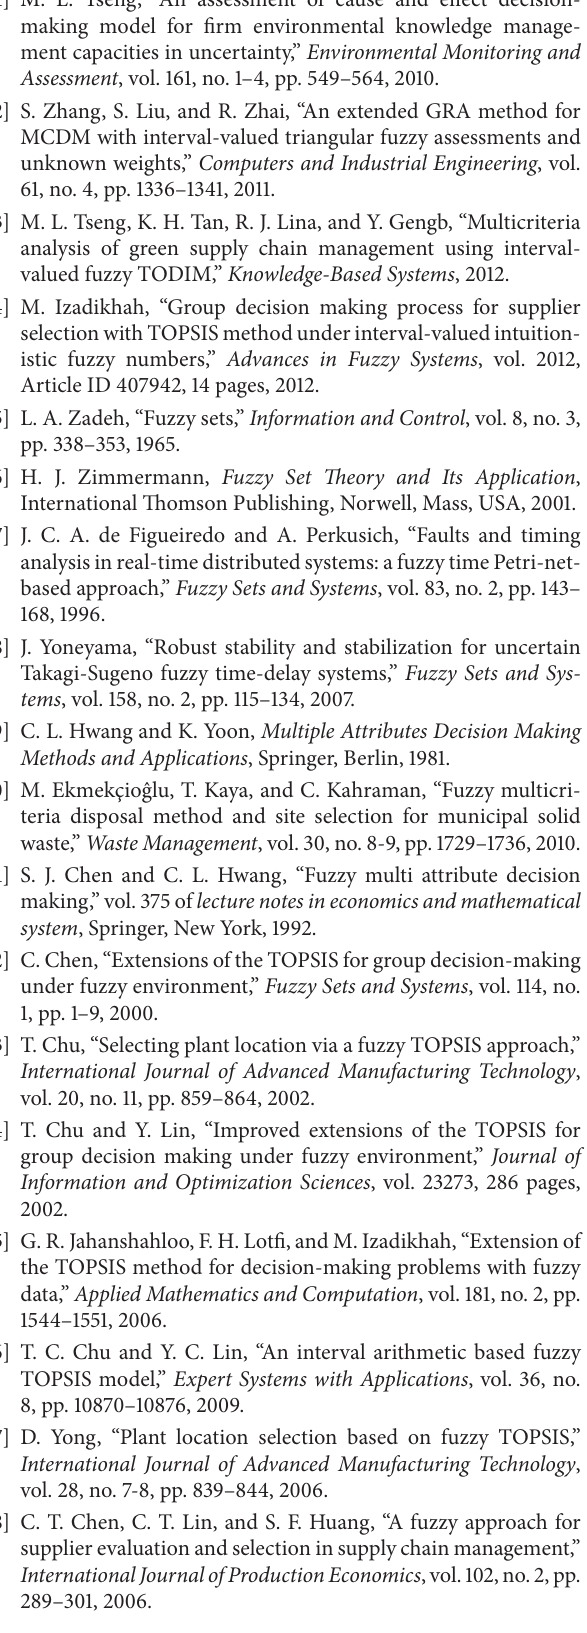
Table 10: Criteria weights.